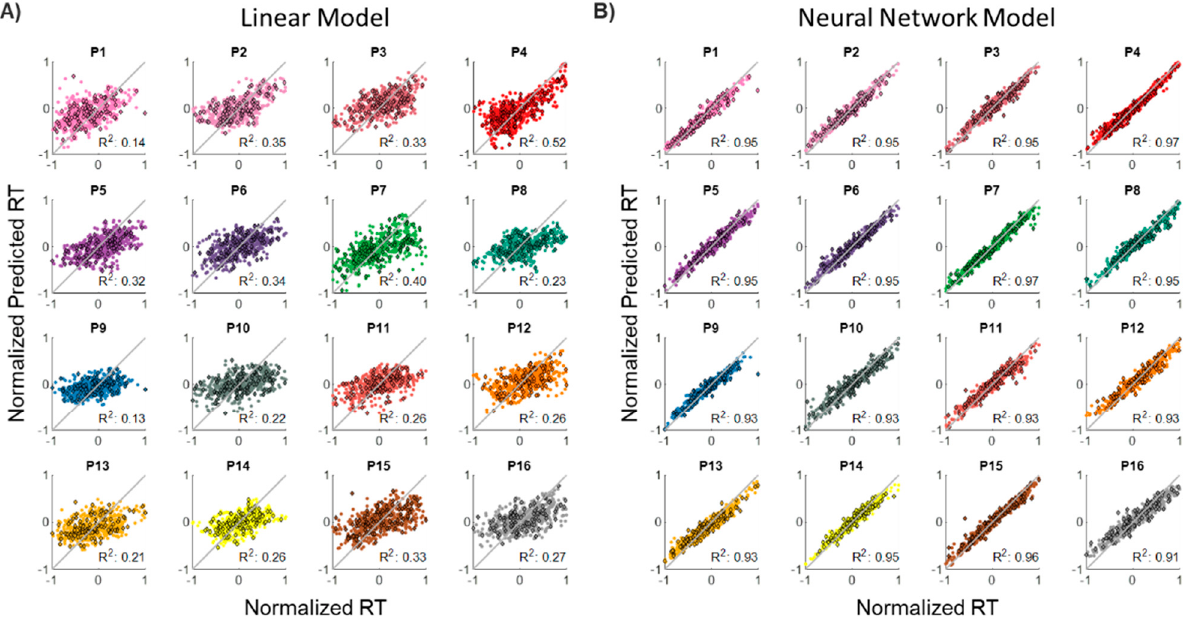
Figure 7. Scatterplots of normalized RT versus the predicted RT for both the ( A ) linear models and ( B ) neural network models, for each